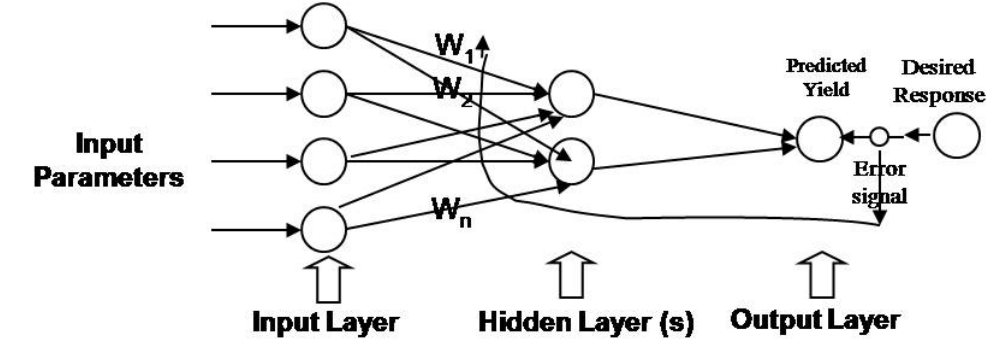
Figure 4. Back propagation neural network (BPNN)